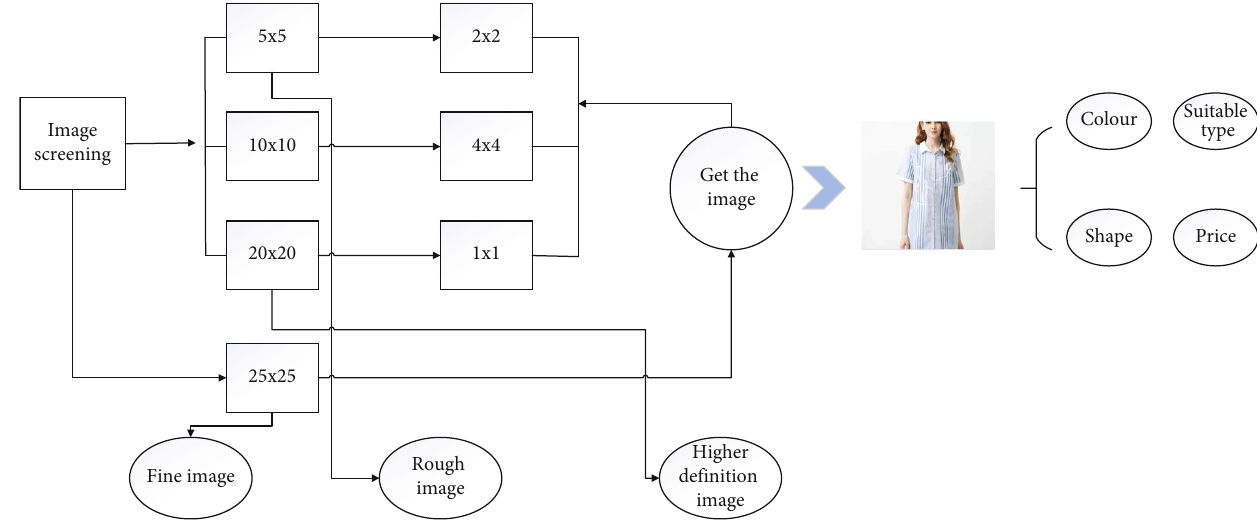
Figure 7: Image retrieval